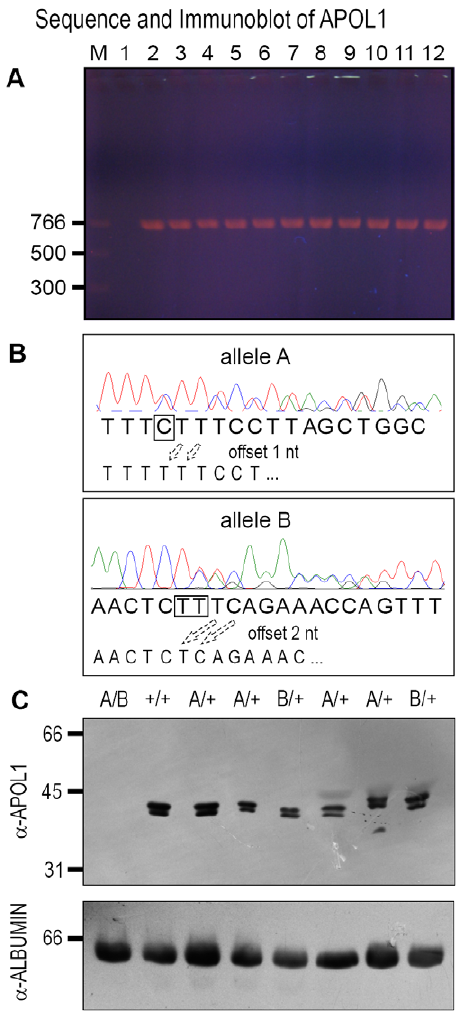
Figure 1. APOL1 null alleles in 51 participants. (A) PCR products that span alleles A and B were amplified from participant genomic DNA and yielded a product of the expected size. Lane M=5 uL Quickload PCR marker. Lanes 1–12 used the same master mix. Lane 1 is water control and lanes 2–12 have 100 ng genomic DNA from different participants. (B) Sanger sequencing identified alleles A and B. Purified PCR products were sequenced with nested internal primers. Sequence tracings are shown for instances in which allele A or allele B was detected. As shown, signal interpretation is clear until the site of the deletion, after which the tracing shows a mixture of two signals. Half of the signal is from the wild type allele, with the expected nucleotide as shown below, and half the signal is from the nucleotide offset by either 1 nt (allele A) or 2 nts (allele B). Additional tracings are available in supplemental data (C) Immunoblots of serum from all 51 participants were probed with a -APOL1. Loading controls used a -albumin as shown or a -transferrin (not shown). M=marker. Lanes 1–8 are participant serum, with a doublet of , 41/39 kDa observed in all lanes except one, which corresponds to the null patient. These blots were confirmed in triplicate.